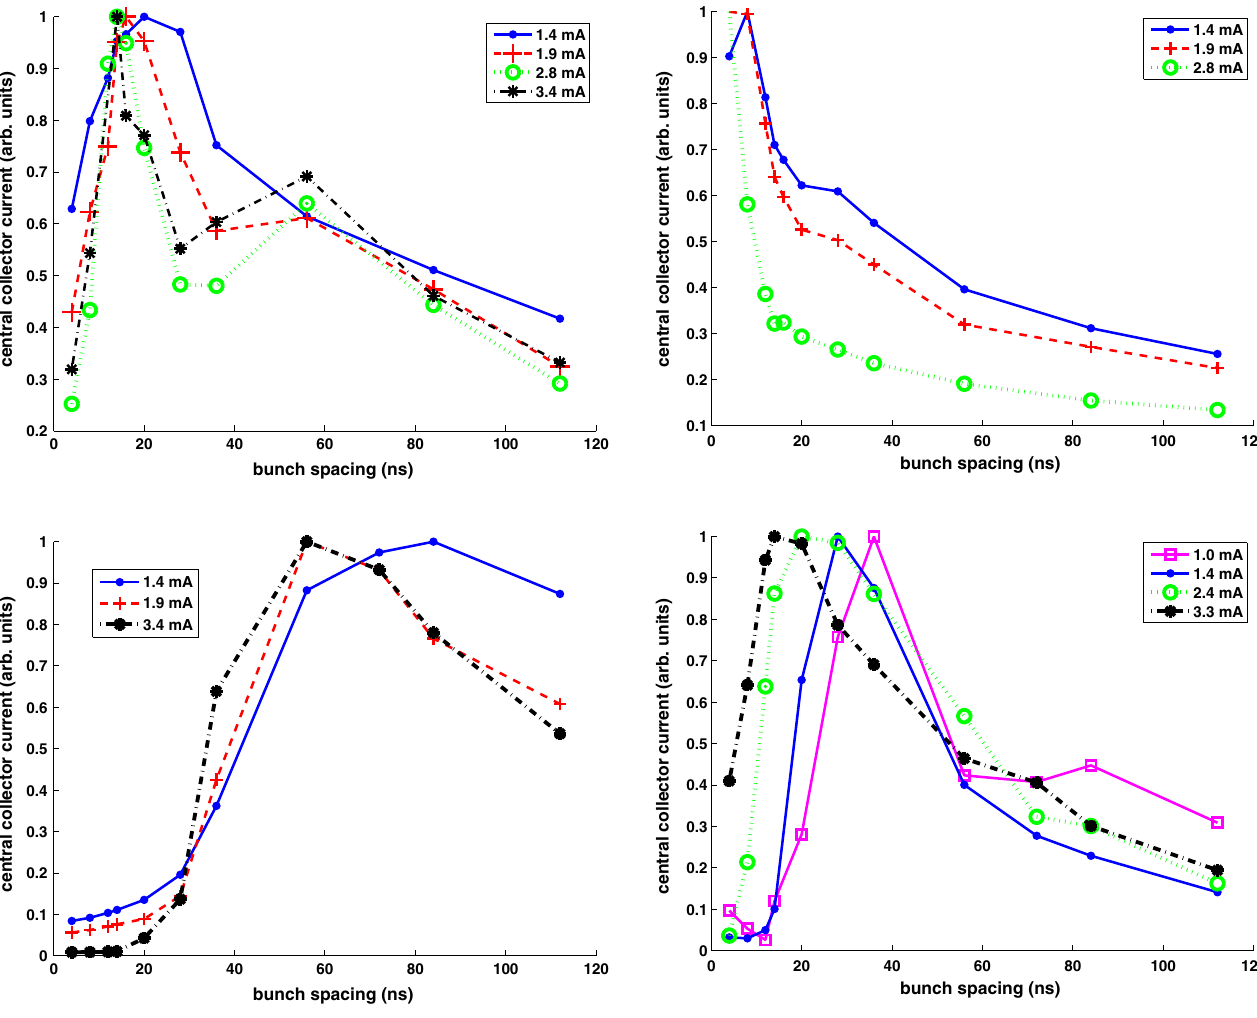
FIG. 3. Central collector signal in the CESR dipole RFA as a function of bunch spacing, at different bunch currents. Top: positron beam; bottom: electron beam. Note that the signals have been normalized to be on the same scale. In absolute terms, the peak positron signal was about 4 times the peak electron